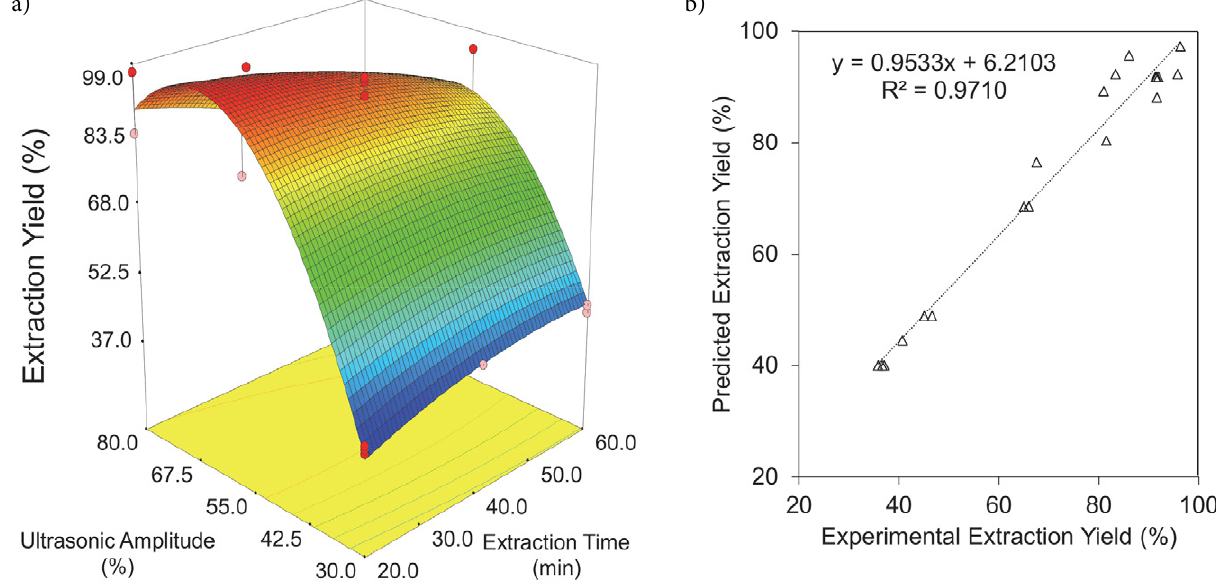
Figure 1. (a) Effect of process parameters on extraction yield and (b) relationship between experimental and predicted extraction yields .